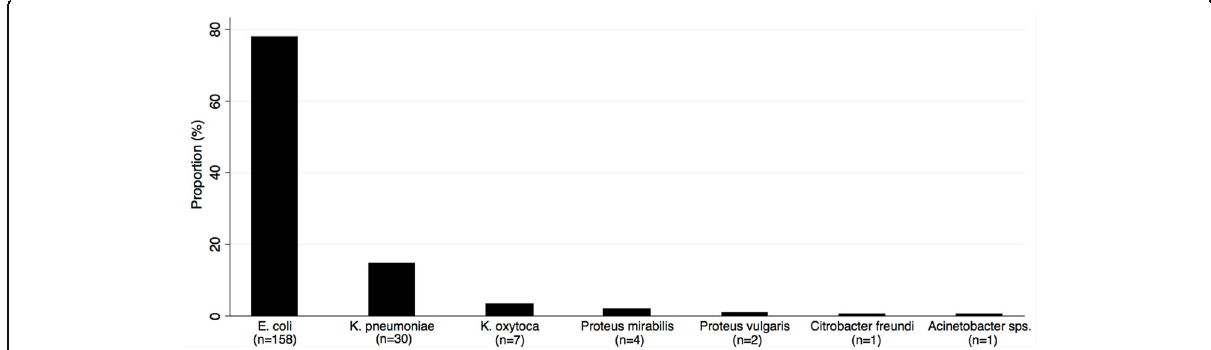
Fig. 1 Distribution of uropathogens in children in Siddhi Memorial Hospital, Bhaktapur, Nepal. The bar graph shows the proportion of the seven types of uropathogens isolated ( n = 203) from 5545 non-repeated urine samples. E. coli (77.8%) and K. pneumoniae (14.8%) were the predominant uropathogens